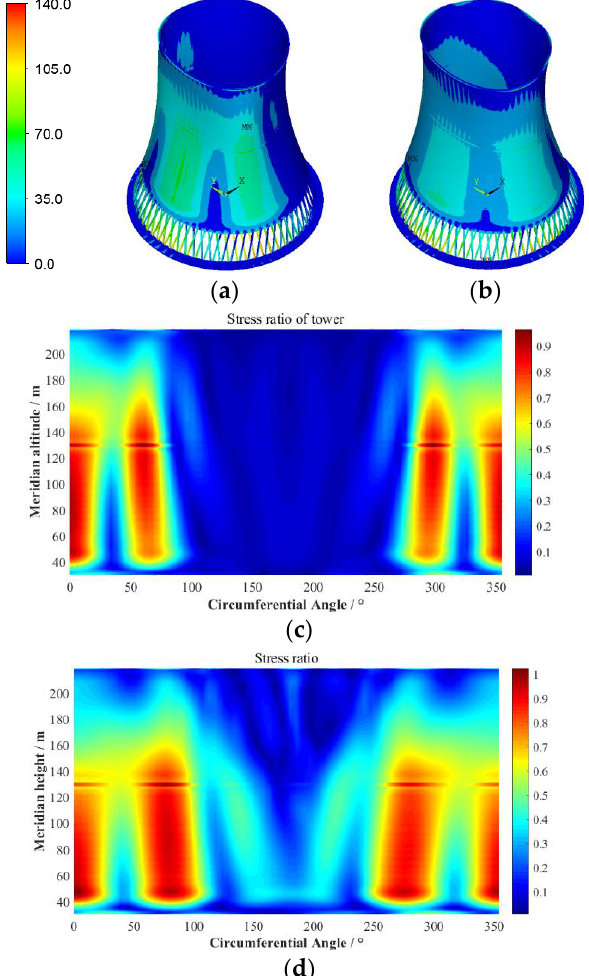
Figure 16. Comparison of the stress response and stress ratio of the tower between normal wind and typhoon. ( a ) 3D meridional stress in Type A. ( b ) 3D meridional stress in typhoon. ( c ) 2D meridional stress ratio of the tower in Type A. ( d ) 2D meridional stress ratio of the tower in typhoon.